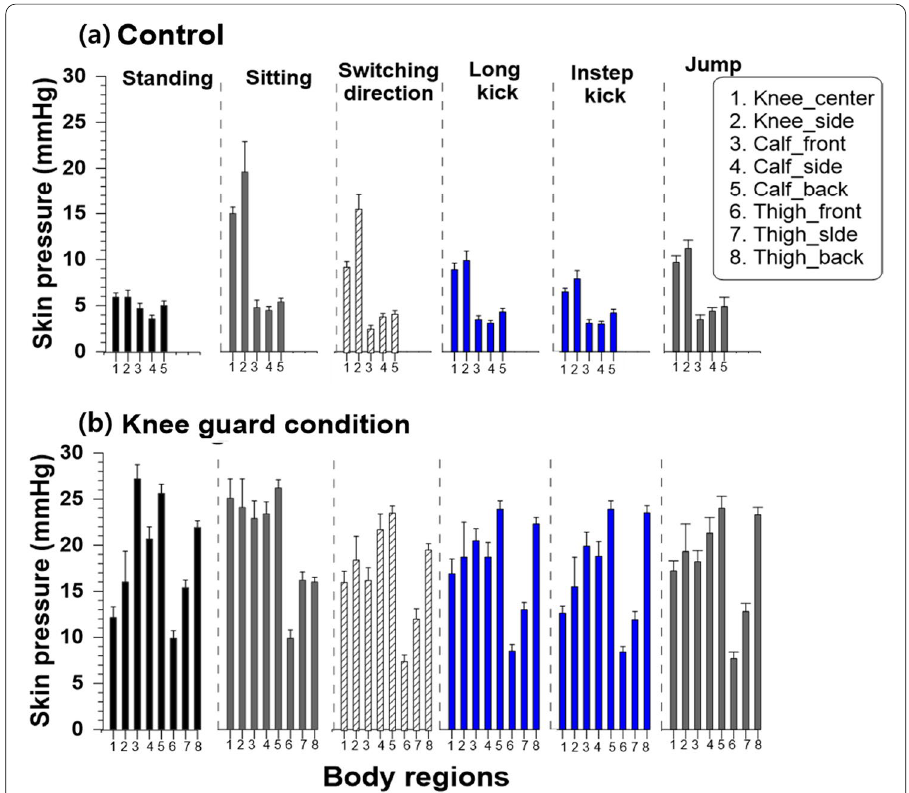
Fig. 3 Body regional skin pressure for the Control ( a ) and the knee guard condition ( b ). Data are expressed as mean SE. The data of the standing posture were averaged from the 1st, 3rd, 5th, 7th, 9th, and 11th standing ±